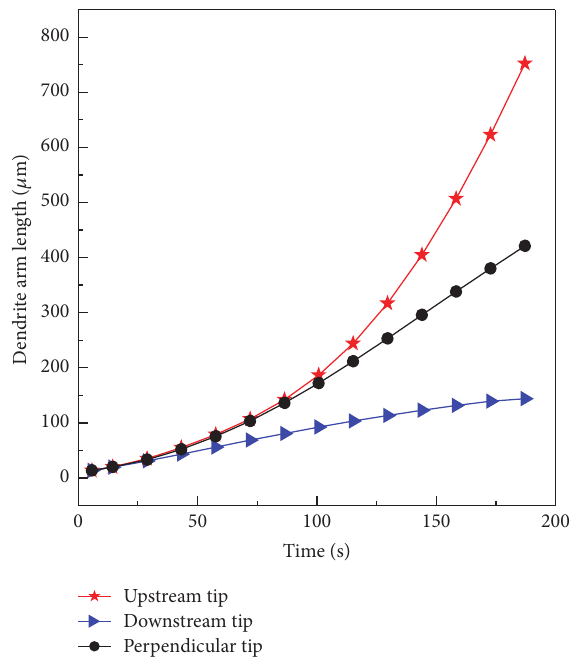
Figure 3: The primary-dendrite arm length with time in the phase- field